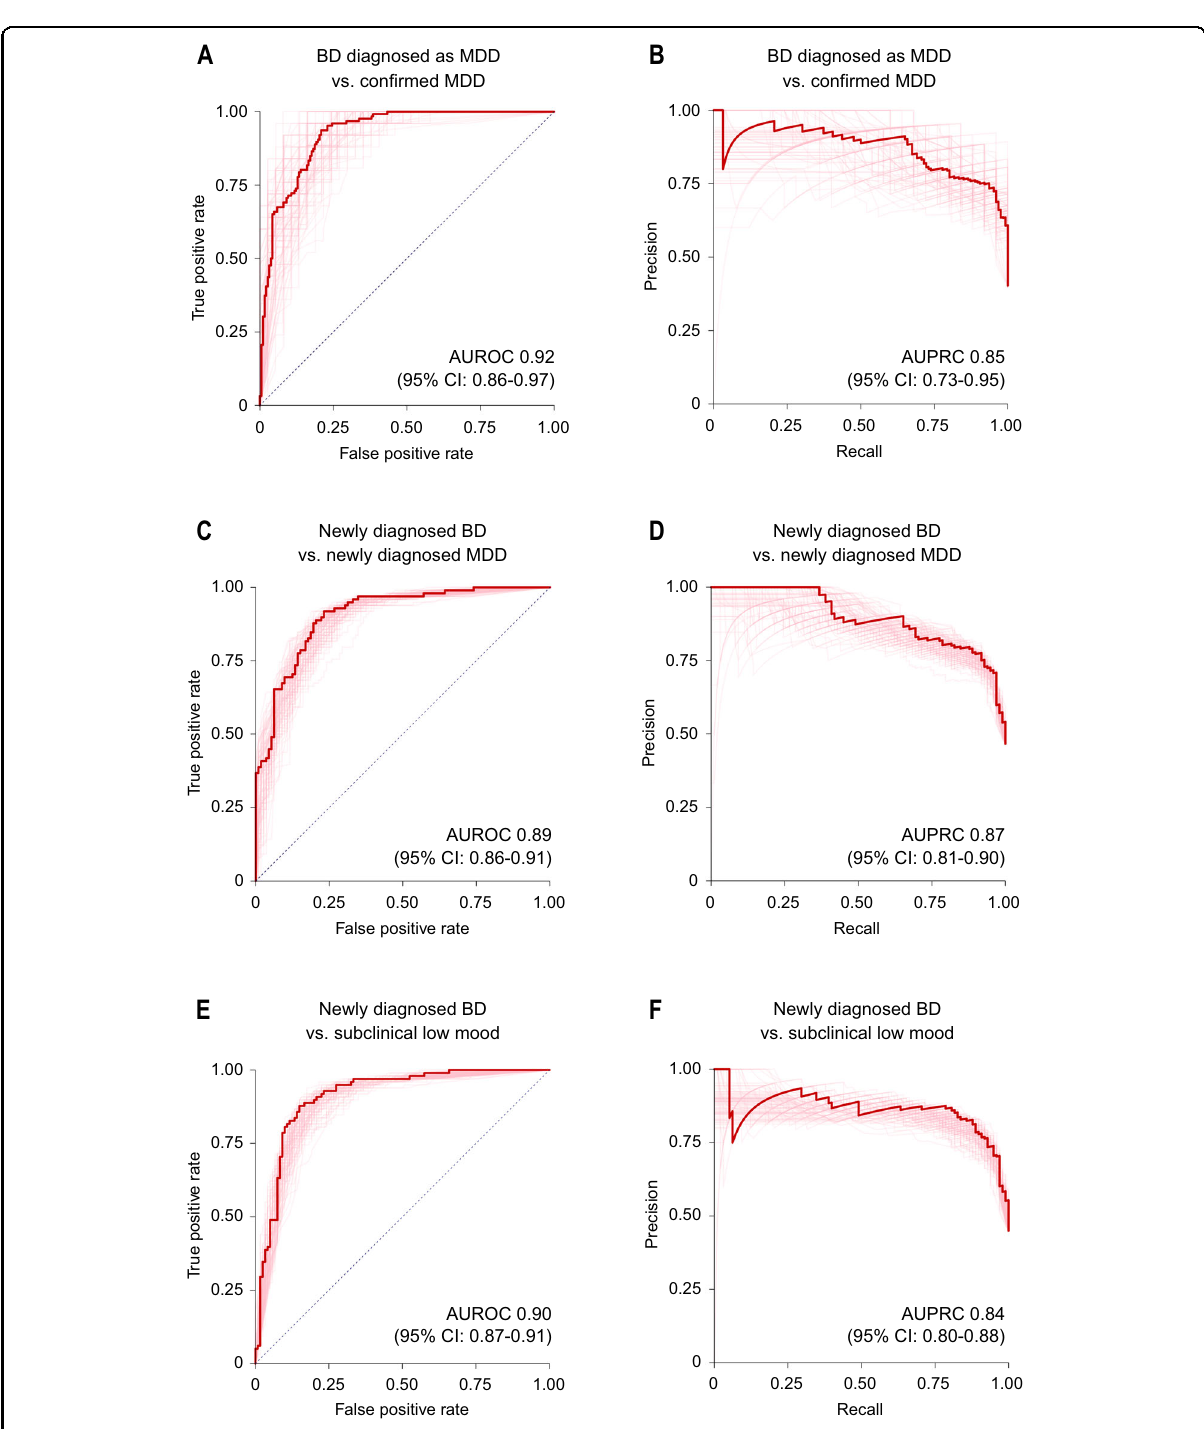
Fig. 2 Receiver operating characteristic and precision-recall curves for prediction of bipolar disorder diagnosis. A , B Out-of-fold results of nested cross-validation in the primary dataset ( N = 126 BD previously diagnosed as MDD vs. N = 187 con fi rmed MDD). Thick lines represent curves calculated from probabilities averaged across all models. C – F Validation in baseline low mood group ( N = 98 newly diagnosed BD vs. N = 112 newly diagnosed MDD ( C , D ) and vs. N = 120 with subclinical depressive symptoms ( E , F )). AUROC and AUPRC values represent mean (95% CI). AUPRC area under the precision-recall curve, AUROC area under the receiver operating characteristic curve, BD bipolar disorder, CI con fi dence intervals, MDD major depressive